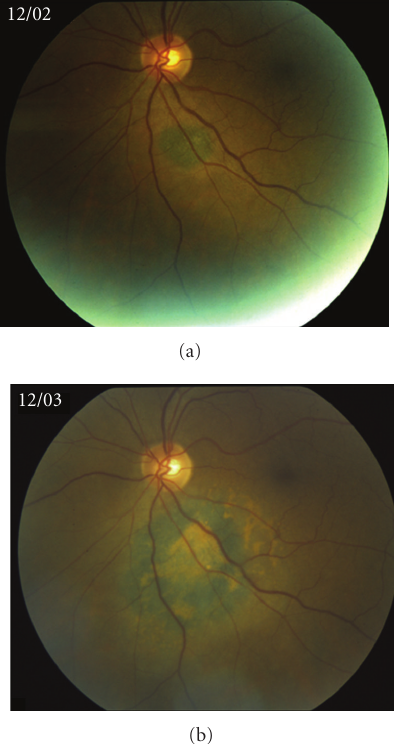
Figure 1: Evolution of choroidal lesion, left eye, over the course of one year.